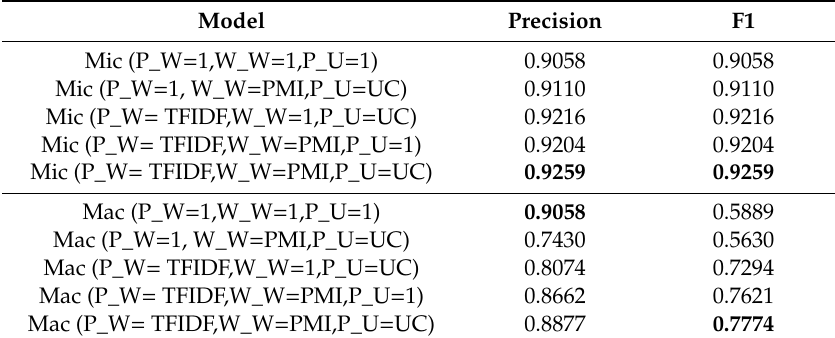
Table 7. Precision and F1 score in our models with di ff erent